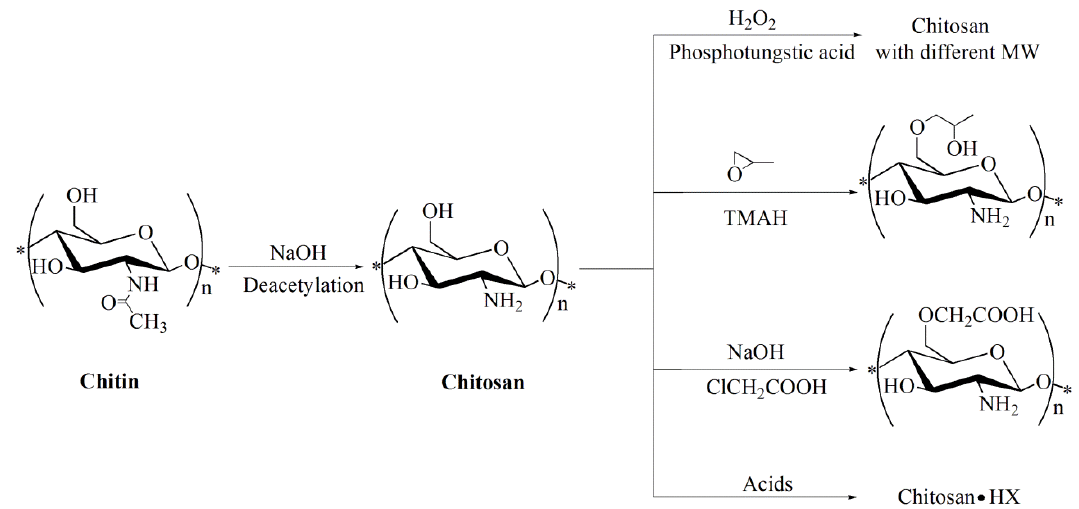
Figure 1. Preparation of chitosan with different molecular parameters.